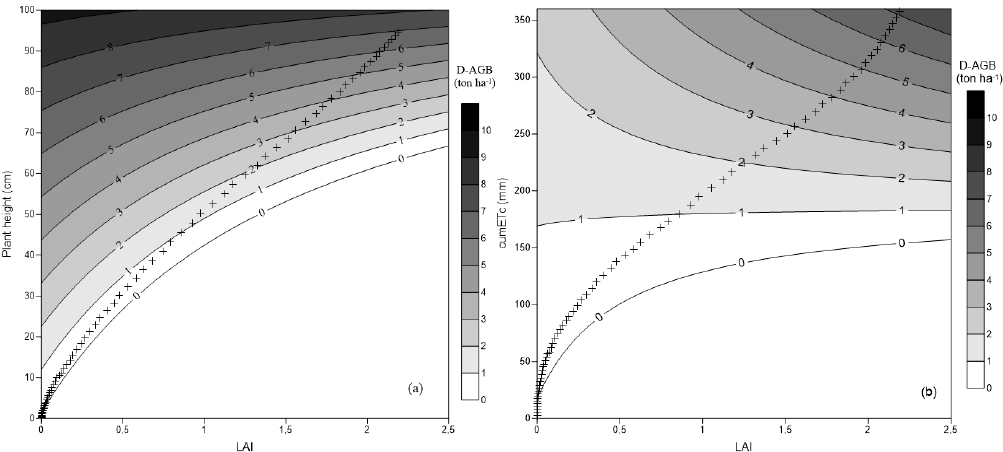
Figure 2. The iso-lines of (D-AGB) derived from Equations (1) and (2). ( a ) first stage ( b ) second stage.